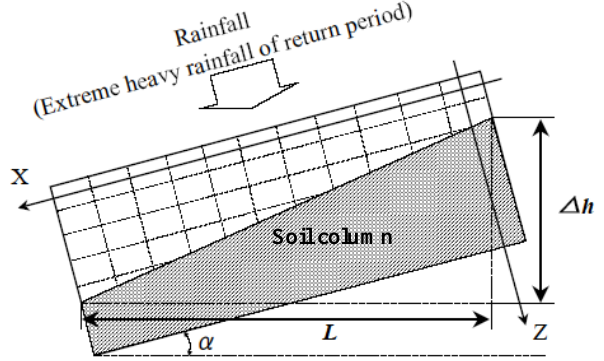
Fig. 1. Schematic diagram for infiltration analysis to obtain the hydraulic Figure 1. Schematic diagram for infiltration analysis to obtain the hydraulic gradient